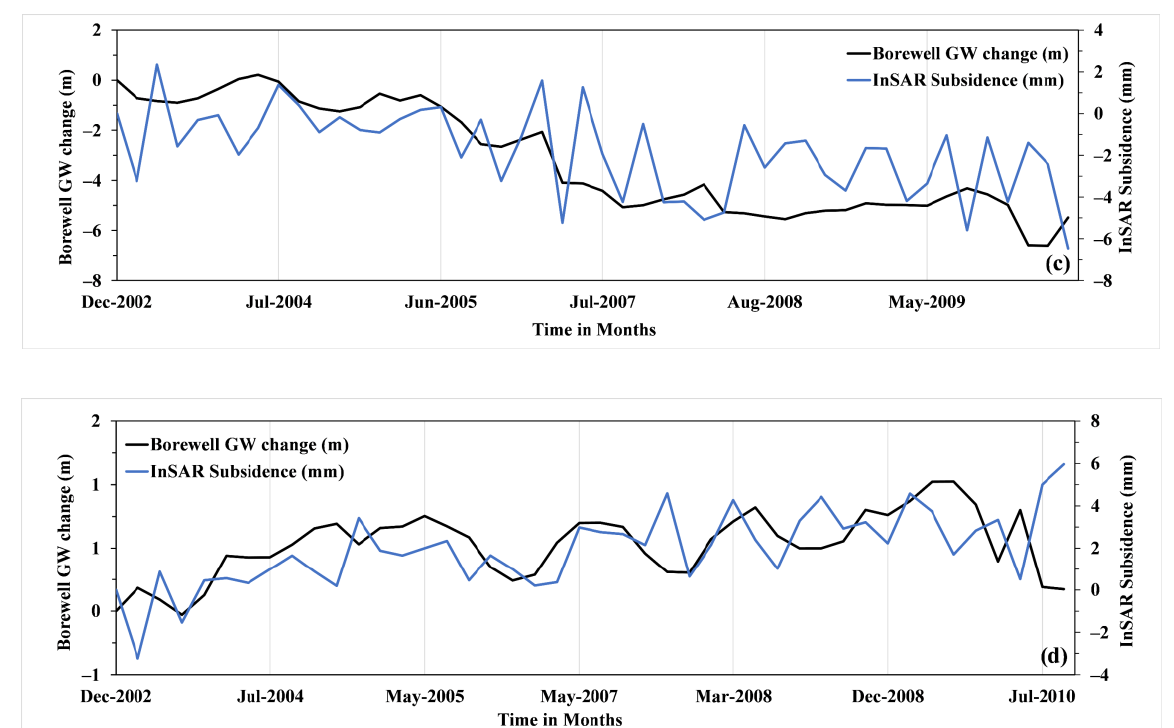
Figure 10. ( a – d ) : Time-series variation of groundwater change (from borehole) and subsidence (from InSAR) for ( a ) TQ2788a (Ashley Gardens, Westminster), ( b ) TQ27_159 (Ram Brewery, High street, Wandsworth), ( c ) TQ28_153 (Kensington Gardens) and ( d ) TQ27_282 (I Stratford Grove, Putney).